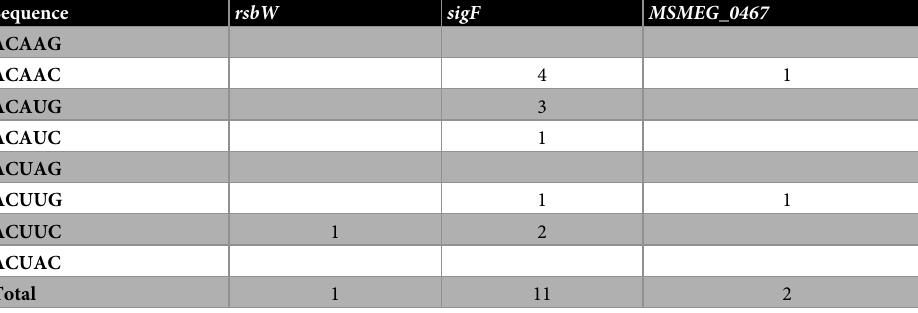
Table 2. Preferred target sequences and their occurrence in the RNA transcripts.